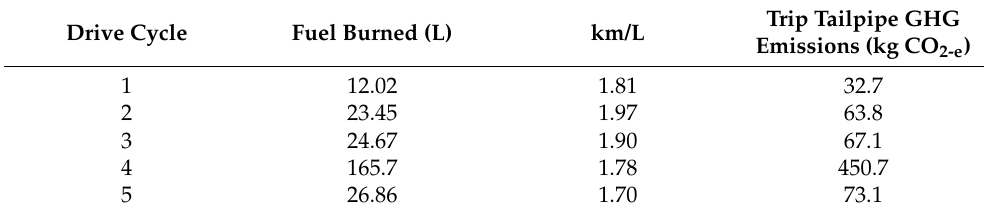
Table 5. Baseline fuel and emission